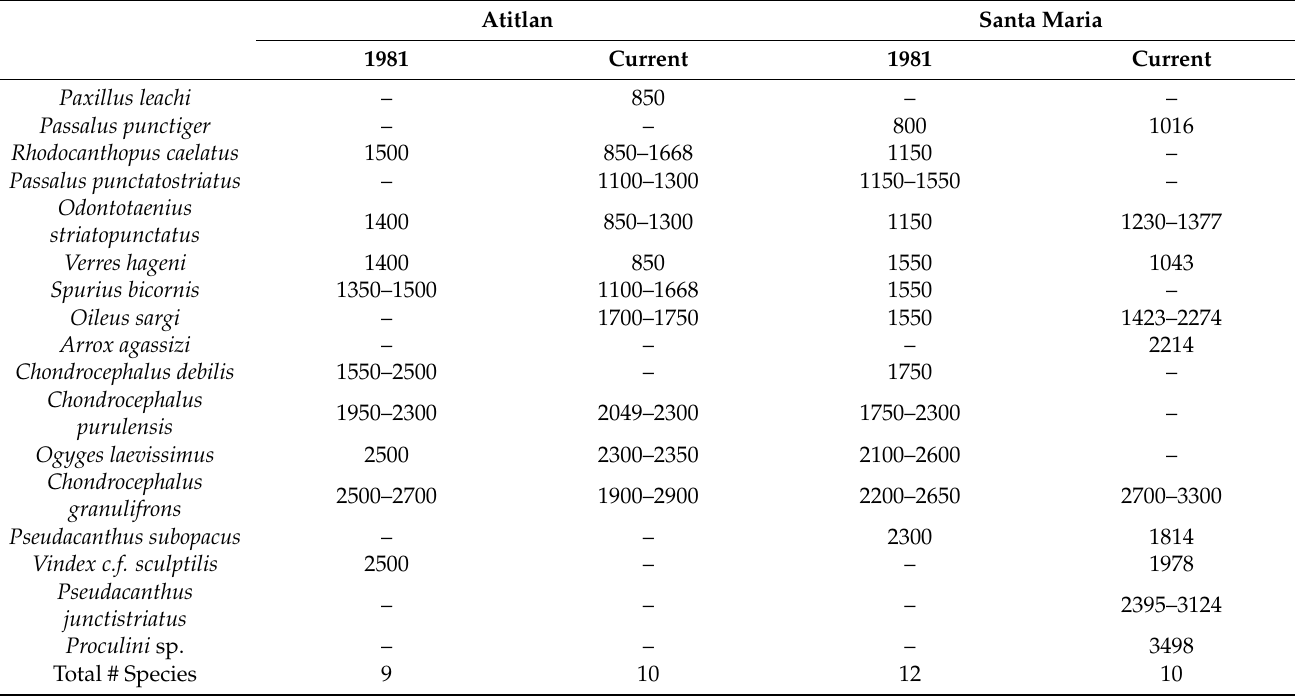
Table 1. Altitudinal ranges (m a.s.l.) of passalid beetles reported in MacVean and Schuster (1981) [9] compared with the beetles collected in this study.